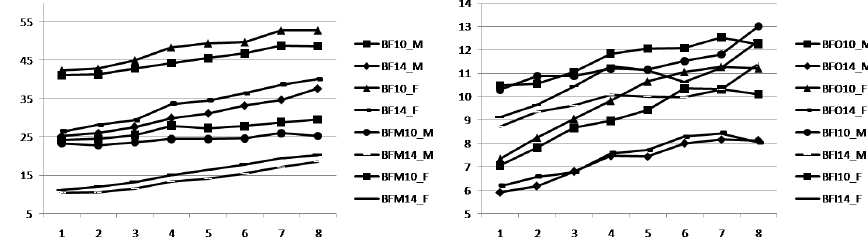
Figure 1. Changes in ultrasonic back fat depth and its layers as functions of scans in pigs of the Iberian breed. Table 4. Allometric coefficients ( R 2 ) for ultrasonic back fat depth and loin area in pigs of the Iberian breed. Scans 1 to 8 Scans 1 to 4